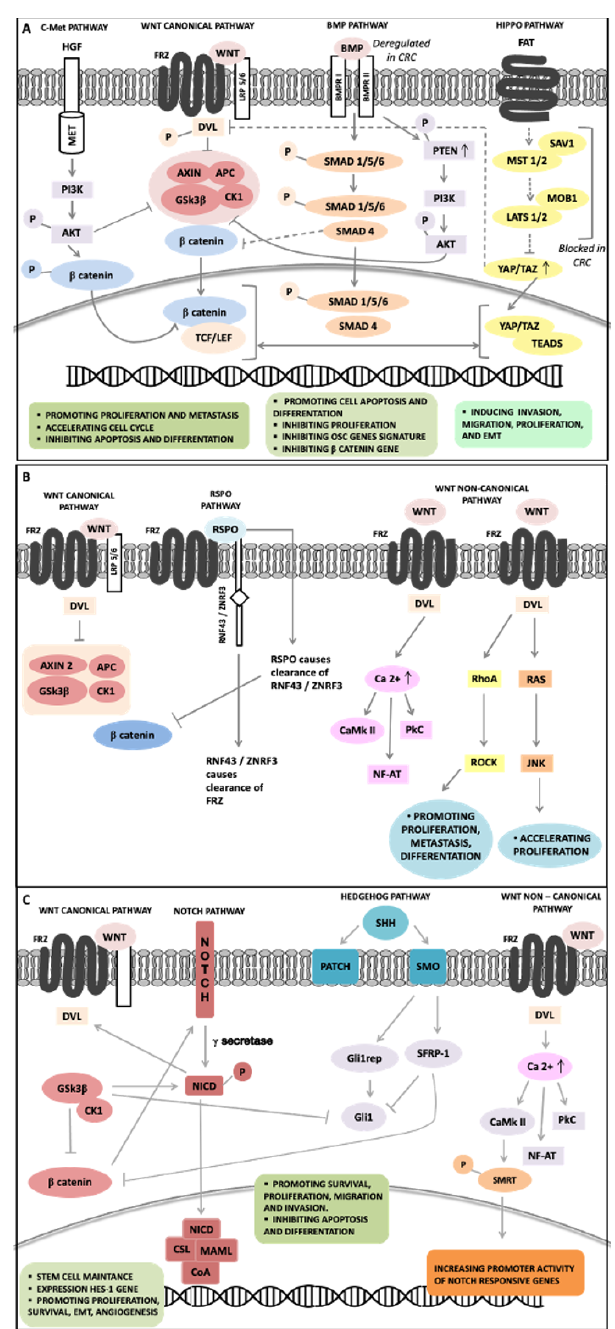
Figure 2. Overview of feedback loops between signaling pathways involved in CRC pathogenesis and controlling stem cell behavior through regulation of β -catenin, a key downstream convergent component. ( A ) c-MET activation induces AKT and GSK3 β phosphorylation leading to LRP5/6 phosphorylation and β -catenin stabilization; deregulation of BMP signaling stabilizes β -catenin by downregulation of SMAD4 and PTEN phosphorylation; Hippo signaling repression stabilizes β -catenin reducing the TAZ-DVL complex in the cytoplasm, while the increasing of TAZ/YAP complex in the nucleus cooperates with β -catenin. ( B ) RSPOs induce RNF43/ZNRF3 ubiquitination improving WNT canonical and non- canonical signaling. ( C ) The interactions between Notch and WNT signaling improve Notch activity, GSK3 β phosphorylates NICD-1 favoring localization in the nucleus, CaMKII induces phosphorylation of SMRT increasing promoter activity of Notch-responsive genes; the crosstalk between Hedgehog and WNT signaling includes Gli-3 phosphorylation by GSK3 β /CK1 blocking Gli-1 activity, SFRP-1 interacts with Gli-1 and β -catenin to control their nuclear– cytoplasmic distributions.